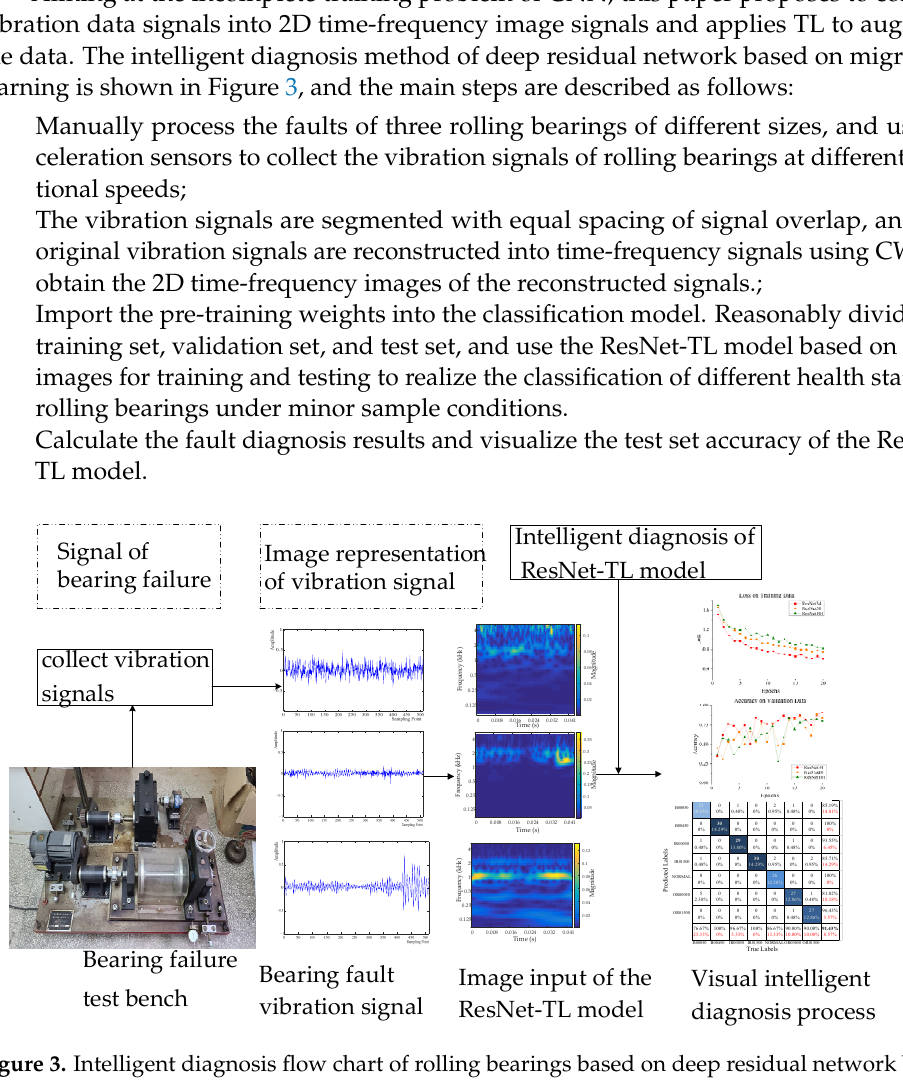
Figure 3. Intelligent diagnosis flow chart of rolling bearings based on deep residual network based on transfer learning.